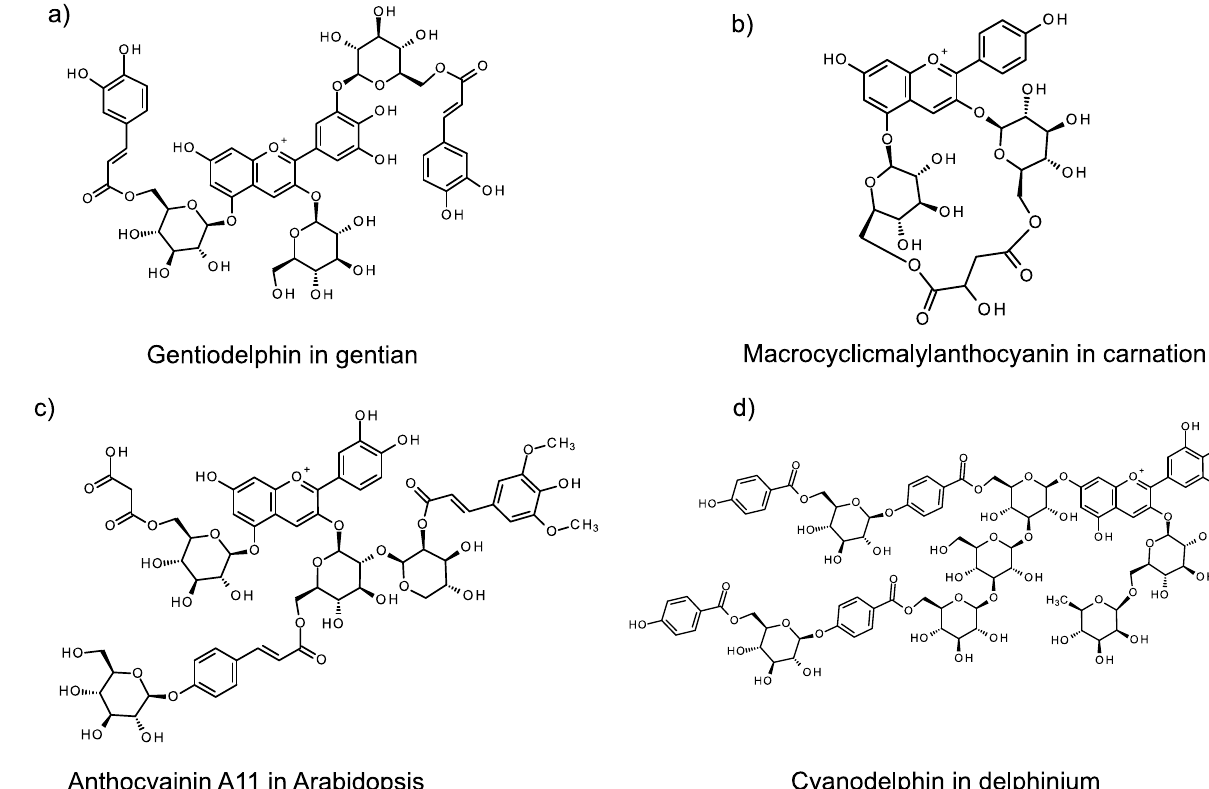
Figure 1. Representative anthocyanins showing modification by sugar and acyl